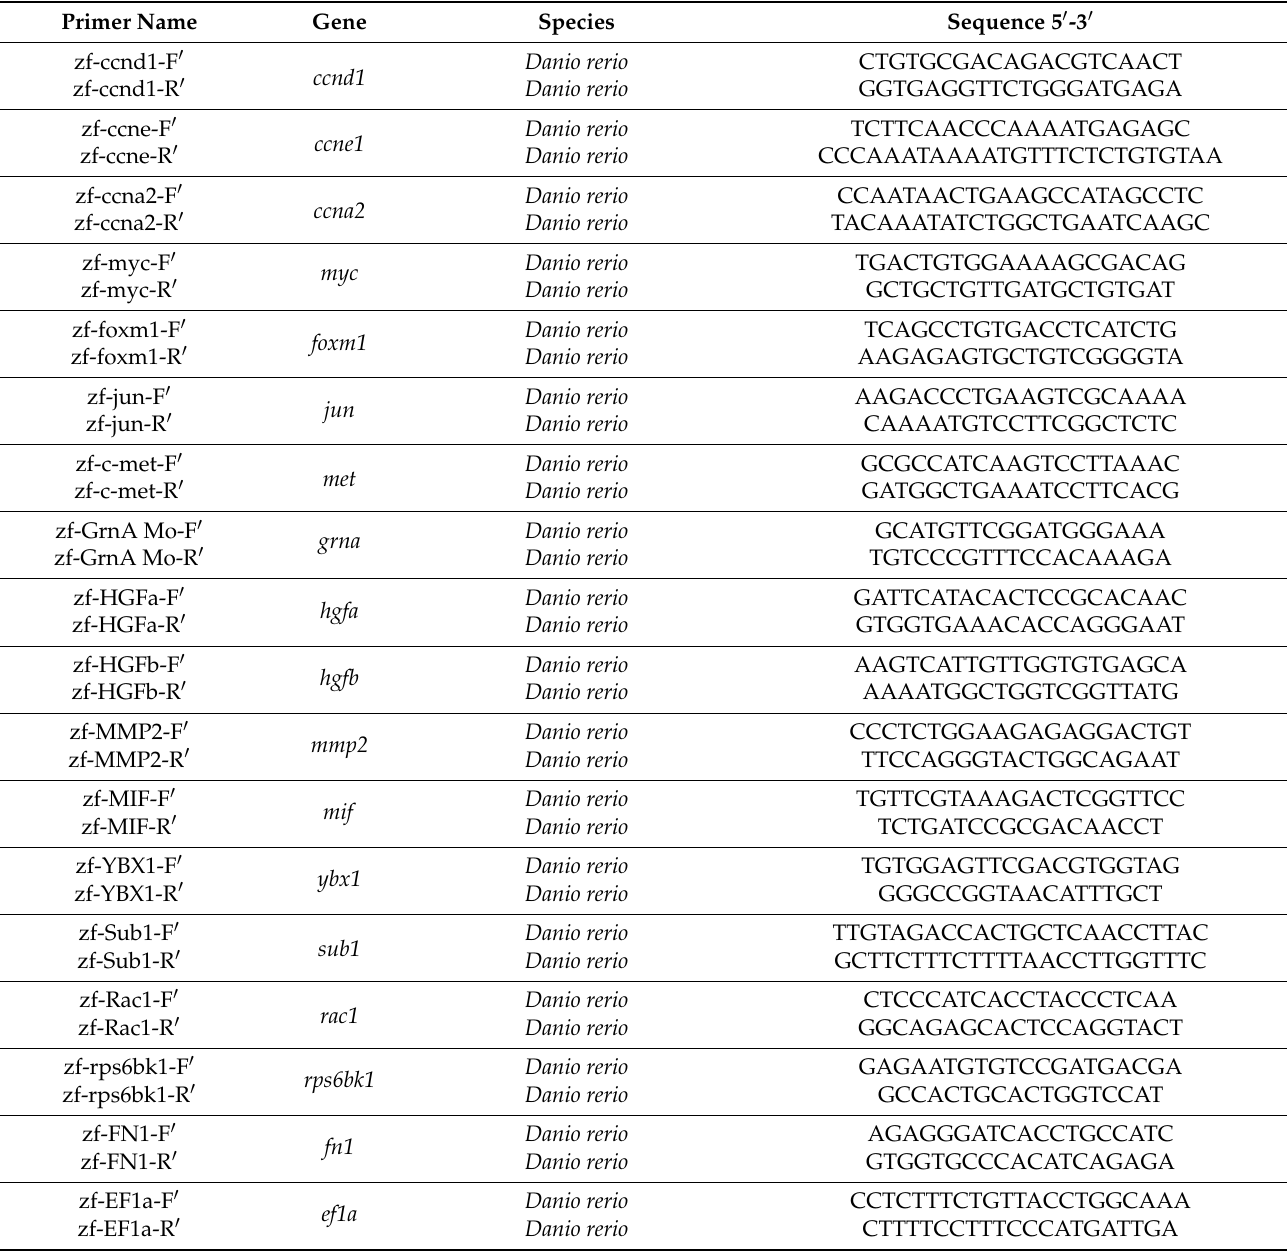
Table 2. Primer sequences for quantitative real-time